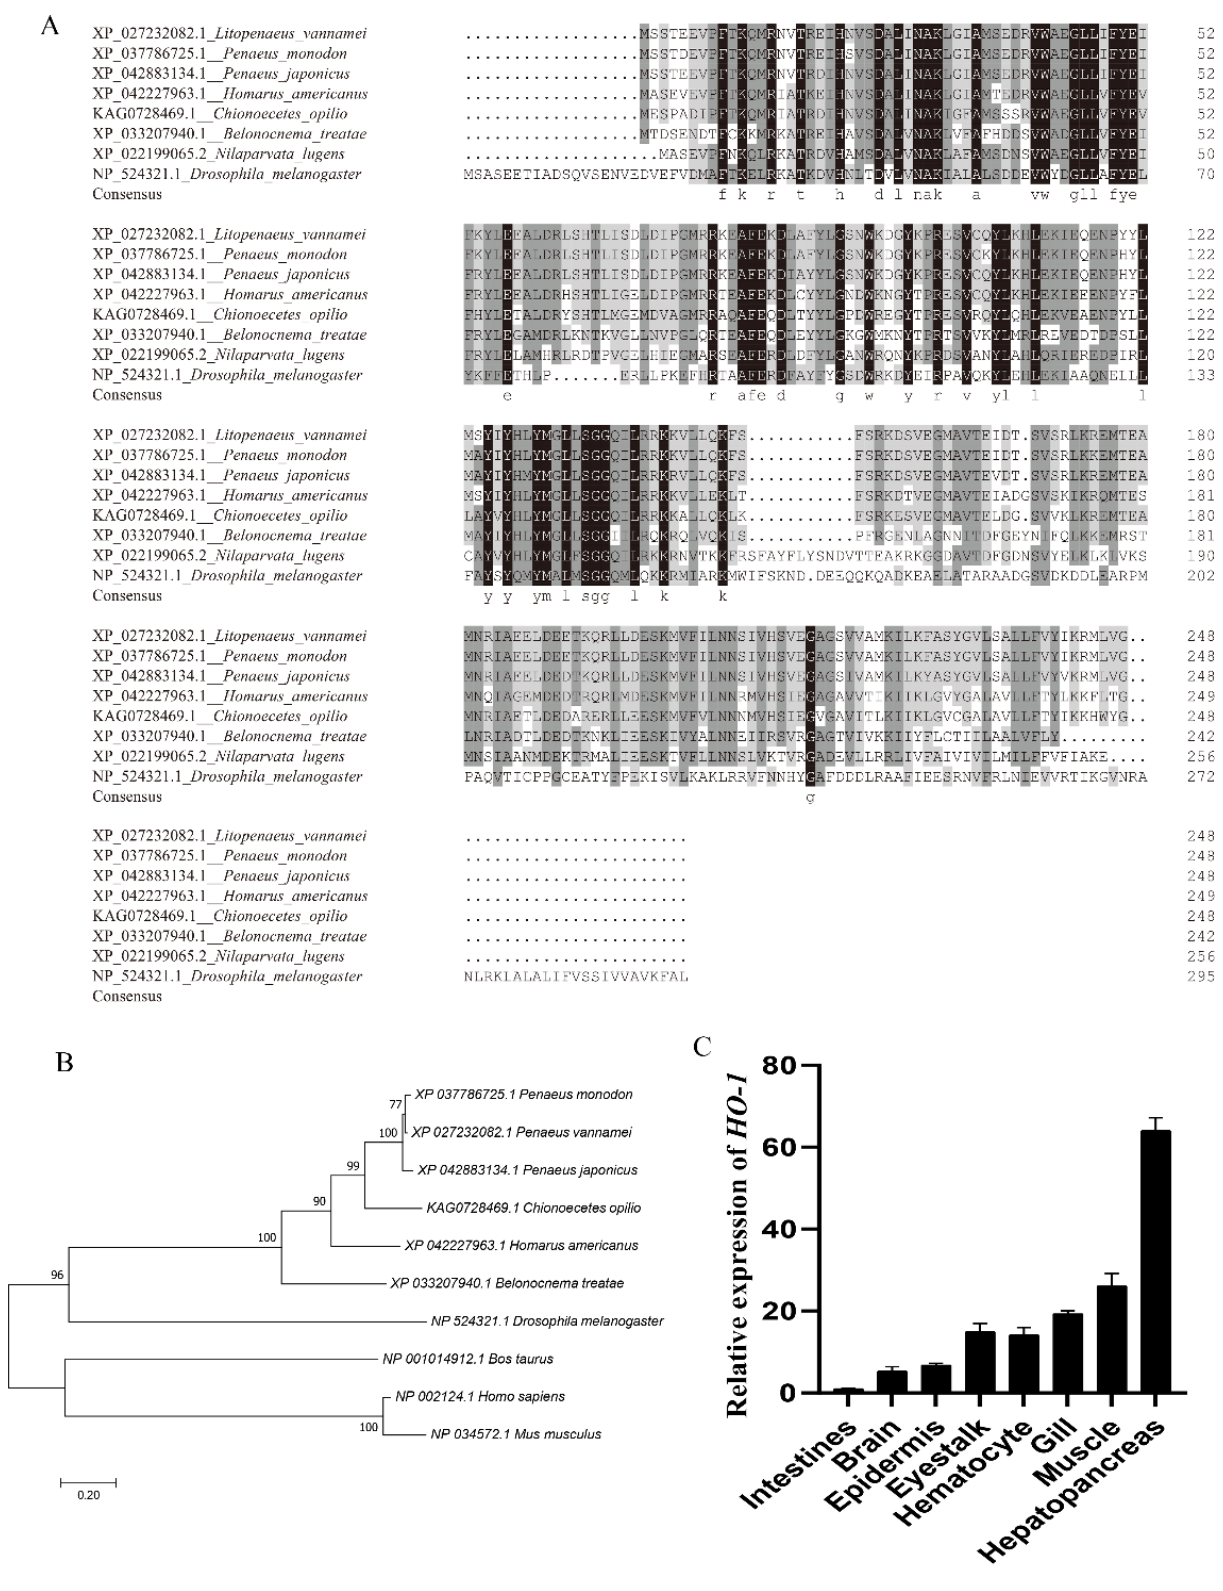
Figure 2. ( A ) Multiple alignments of the HO-1 sequence from various species. ( B ) Phylogenetic tree of the Lv-HO-1 family built via neighbor joining. ( C ) Lv-HO-1 levels in different tissues in L. vannamei were evaluated via qRT-PCR. All values are the mean ± SD; n = 3.